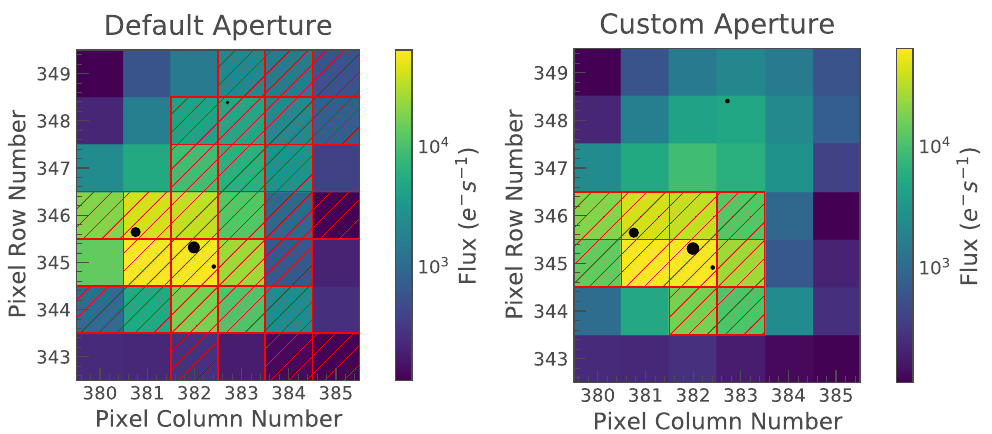
Figure 4. Similar with Figure 1 but for KIC 5480114. The largest black point in the middle is the target star. KIC 5480114 has one bright neighbor on the left side, and two faint neighbors on the lower and upper right.